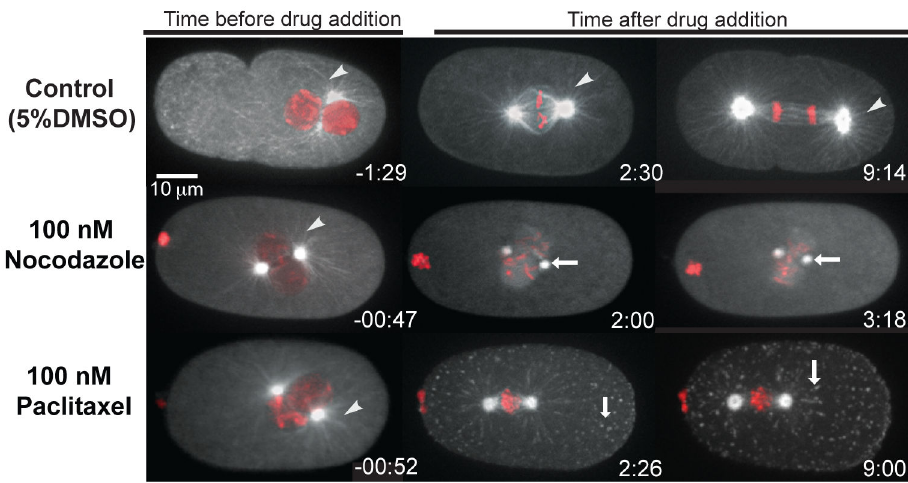
Figure 1. Drug tests on permeabilized embryos. Confocal images of embryos expressing GFP-tubulin and mCherry-histone are shown. The posterior of the embryos are to the right. The control embryo treated with 5% DMSO divided normally. The white arrowhead points to the microtubule fibres, which were observed in all embryos before drug addition. Embryos treated with nocodazole and paclitaxel did not divide and microtubule fibres were seen in the time frame before drug addition indicated by white arrowheads. In nocodazole-treated embryo, fluorescence was visible only at the centrosomes (white arrows) and the centrosomes gradually drifted towards each other. In paclitaxel treated embryos, white arrows indicate tubulin aggregates in the cytoplasm. doi: